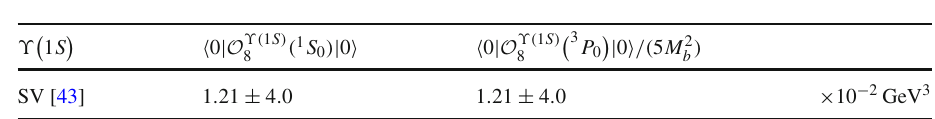
Table 2 Numerical values of the LDMEs for ϒ( 1 S )